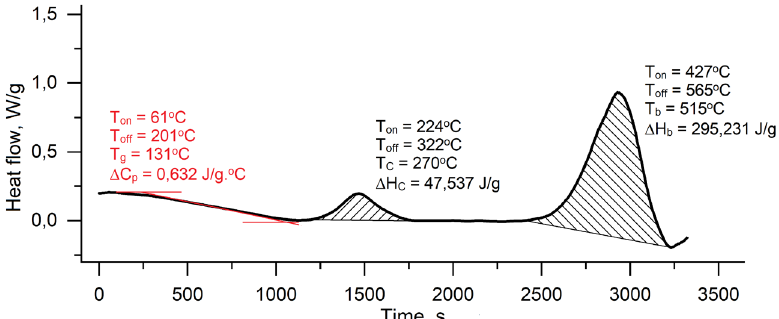
Figure 2: DSC curve of epoxy resin specimen without quenching.